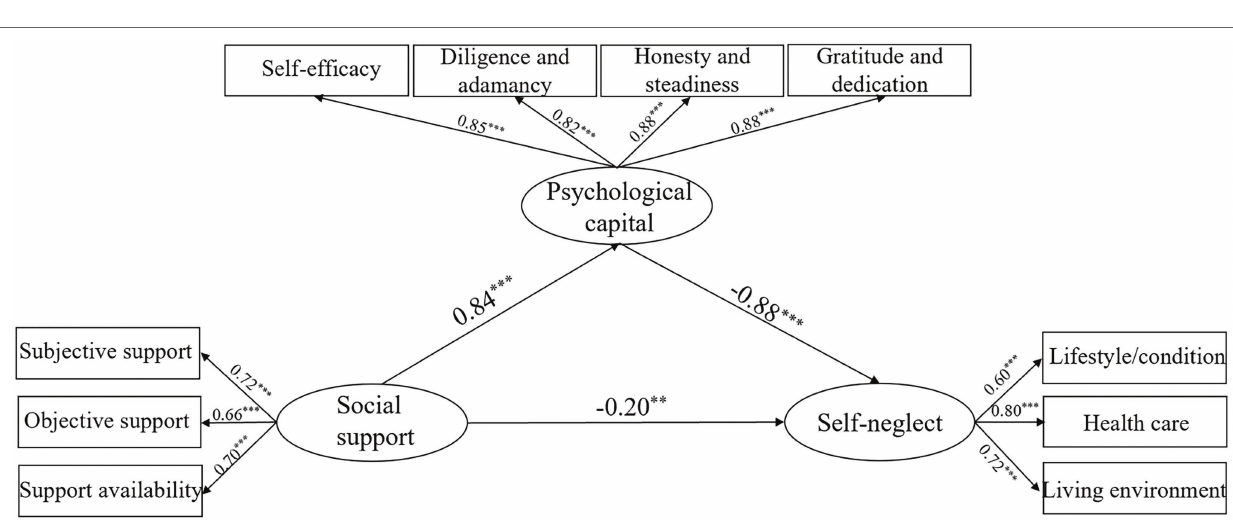
FIGURE 2 | Standardized solution for the structural equation model of psychological capital, social support, and self-neglect. ** p < 0.01 and *** p <